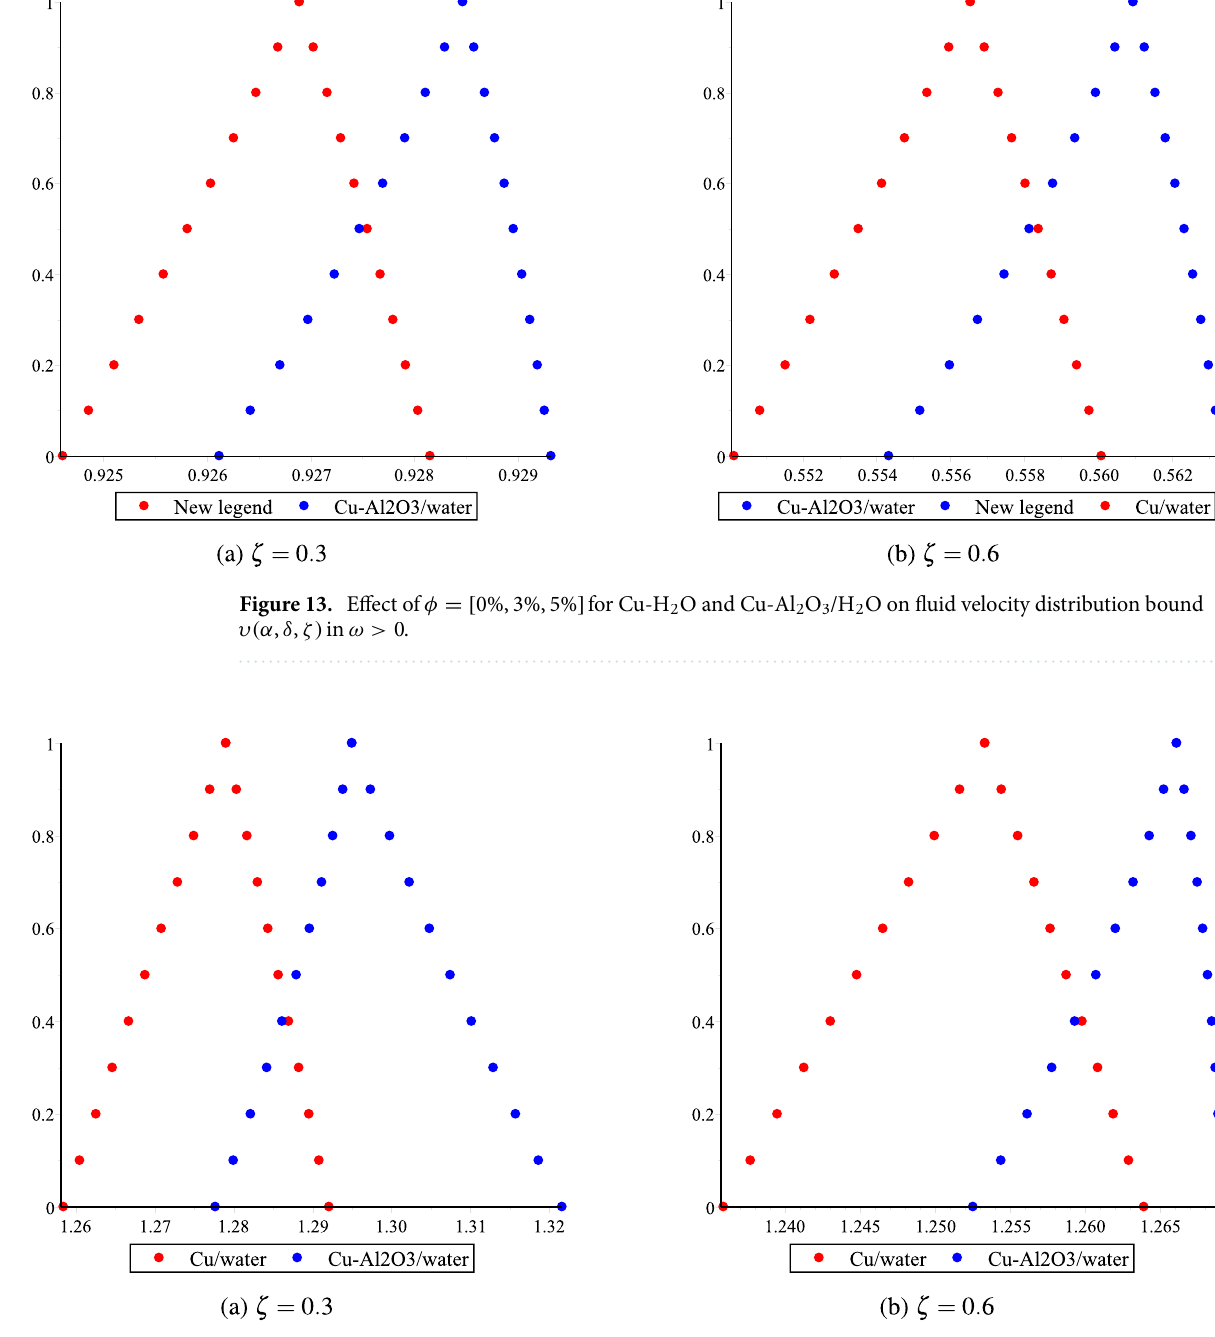
Figure 14. Effect of φ = [ 0%, 3%, 5% ] for Cu-H 2 O and Cu-Al 2 O 3 /H 2 O on fluid temperature distribution bound υ(α , δ , ζ) in ω < 0 .